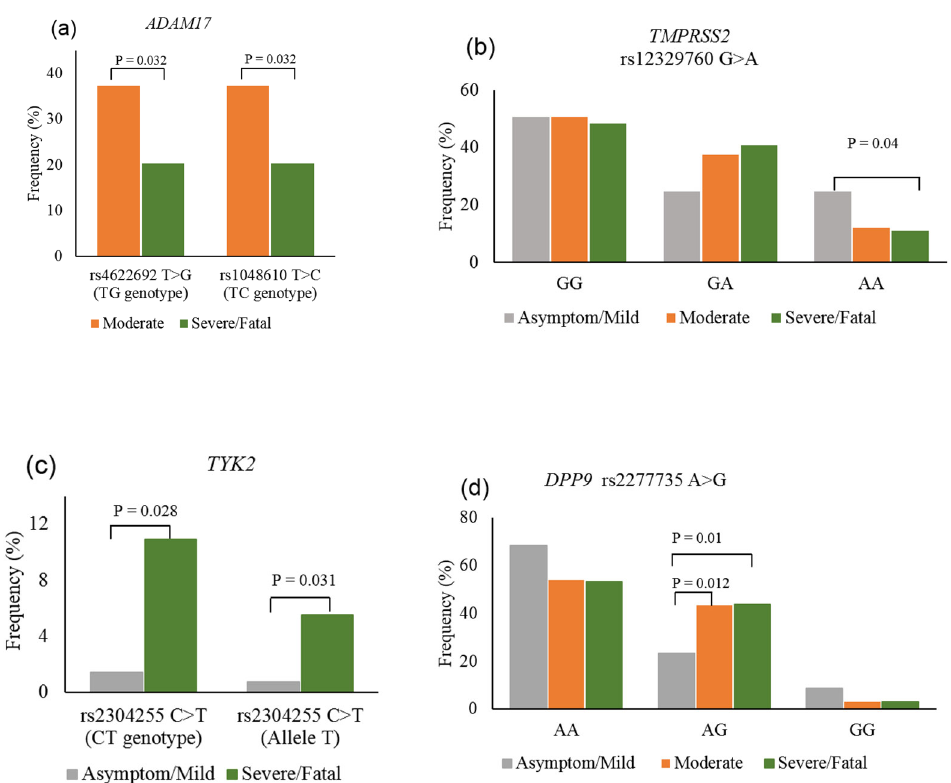
Figure 3. Genotype and allele frequency of ADAM17 , TMPRSS2 , TYK2, and DPP9 in COVID-19 patients. ( a ) For ADAM17 , the frequency of TG genotype of rs4622692 and TC genotype of rs1048610 in the moderate group were significantly higher than in the severe/fatal group, ( b ) for TMPRSS2 rs12329760, the frequency of AA genotype in asymptomatic/mild cases was significantly higher than that in severe/fatal cases, ( c ) for TYK2 rs2304255, CT genotype and allele T in severe/fatal cases were significantly higher than those in the asymptomatic/mild cases, ( d ) for DPP9 rs2277735, heterozygous AG genotype showed a significantly higher frequency in moderate and severe/fatal groups compared with that in the asymptomatic/mild